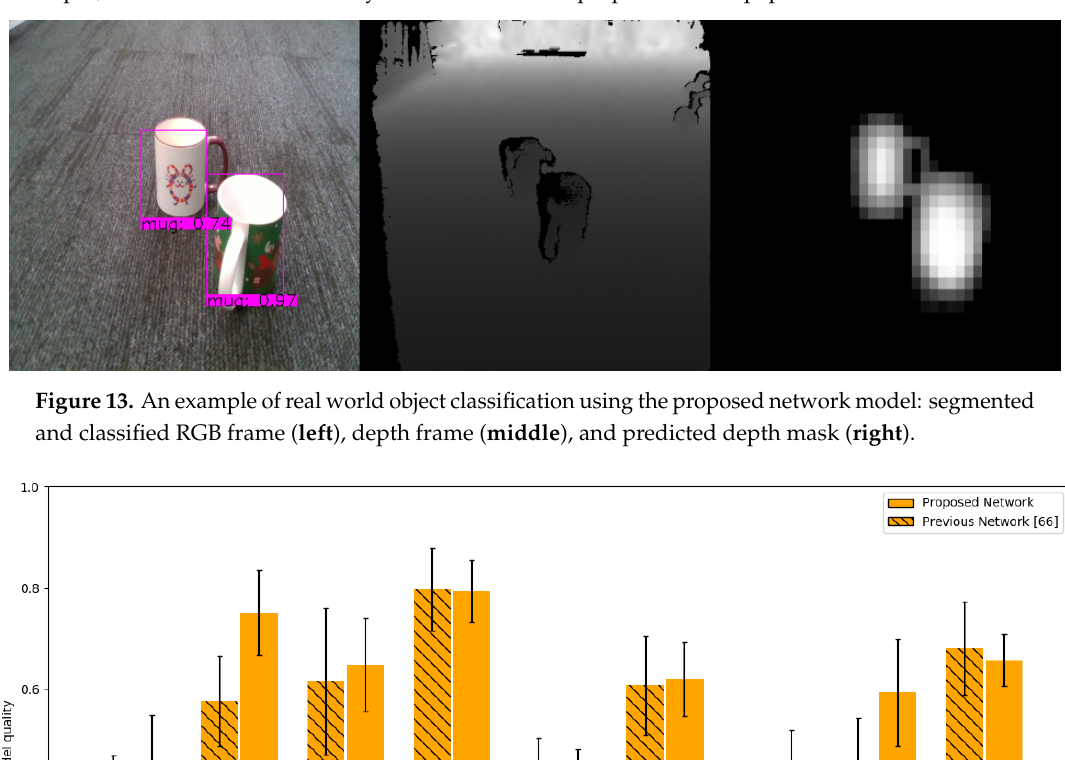
Figure 12. Similarity of created mask to the mask of ground truth. The hashed bar denotes the similarity of masks predicted by the YOLOv3 network, the solid bar denotes the similarity of masks predicted for Depth, RGB-D and RGB frames by the network model proposed in this paper.